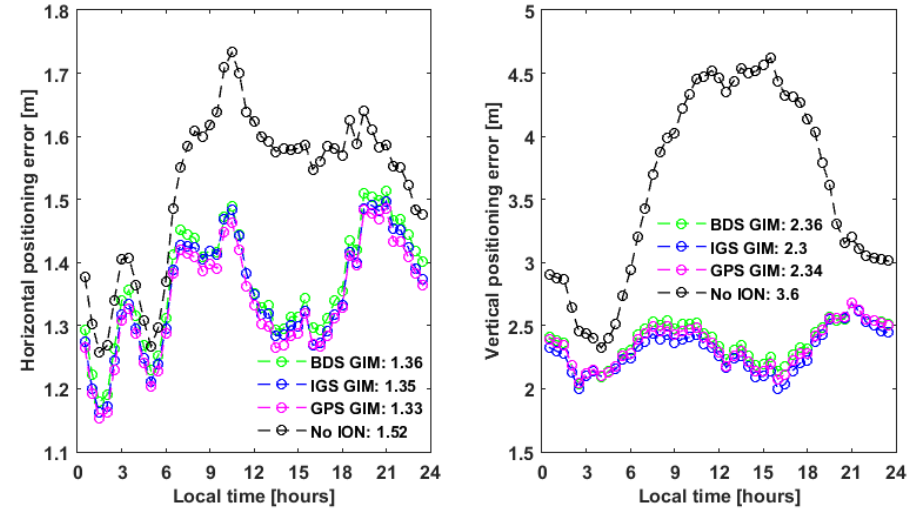
Figure 20. Horizontal ( left panel) and vertical ( right panel) positioning errors with respect to local time during the period from DOY 214 to 244 in 2020.